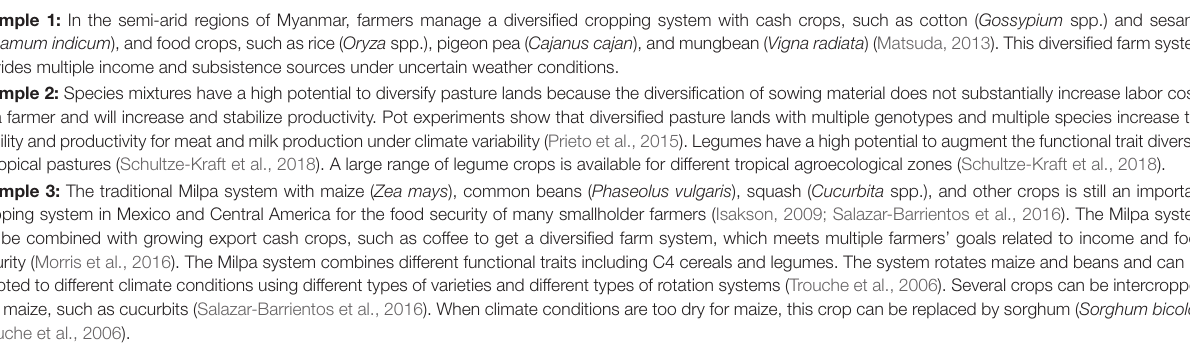
TABLE 4 | Successful examples of diversified cropping, pasture, and agroforestry systems. Example 1: In the semi-arid regions of Myanmar, farmers manage a diversified cropping system with cash crops, such as cotton ( Gossypium spp.) and sesame ( Sesamum indicum ), and food crops, such as rice ( Oryza spp.), pigeon pea ( Cajanus cajan ), and mungbean ( Vigna radiata ) (Matsuda, 2013). This diversified farm system provides multiple income and subsistence sources under uncertain weather